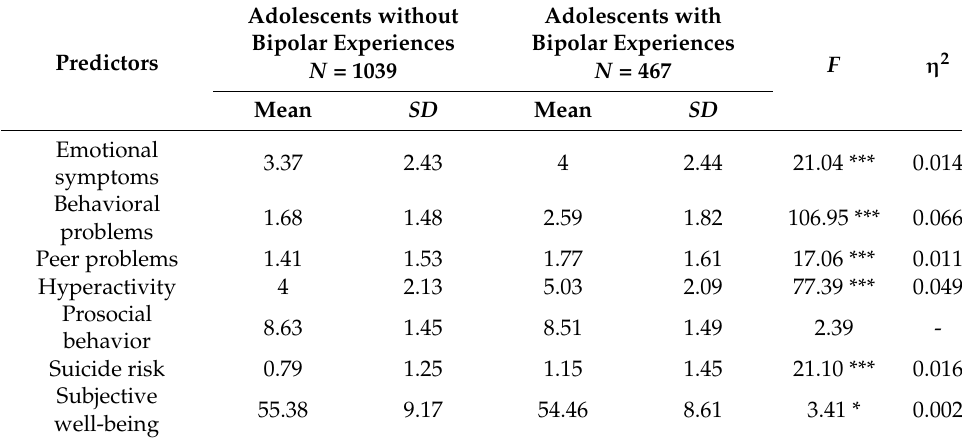
Table 1. Mean differences between adolescents without and with bipolar